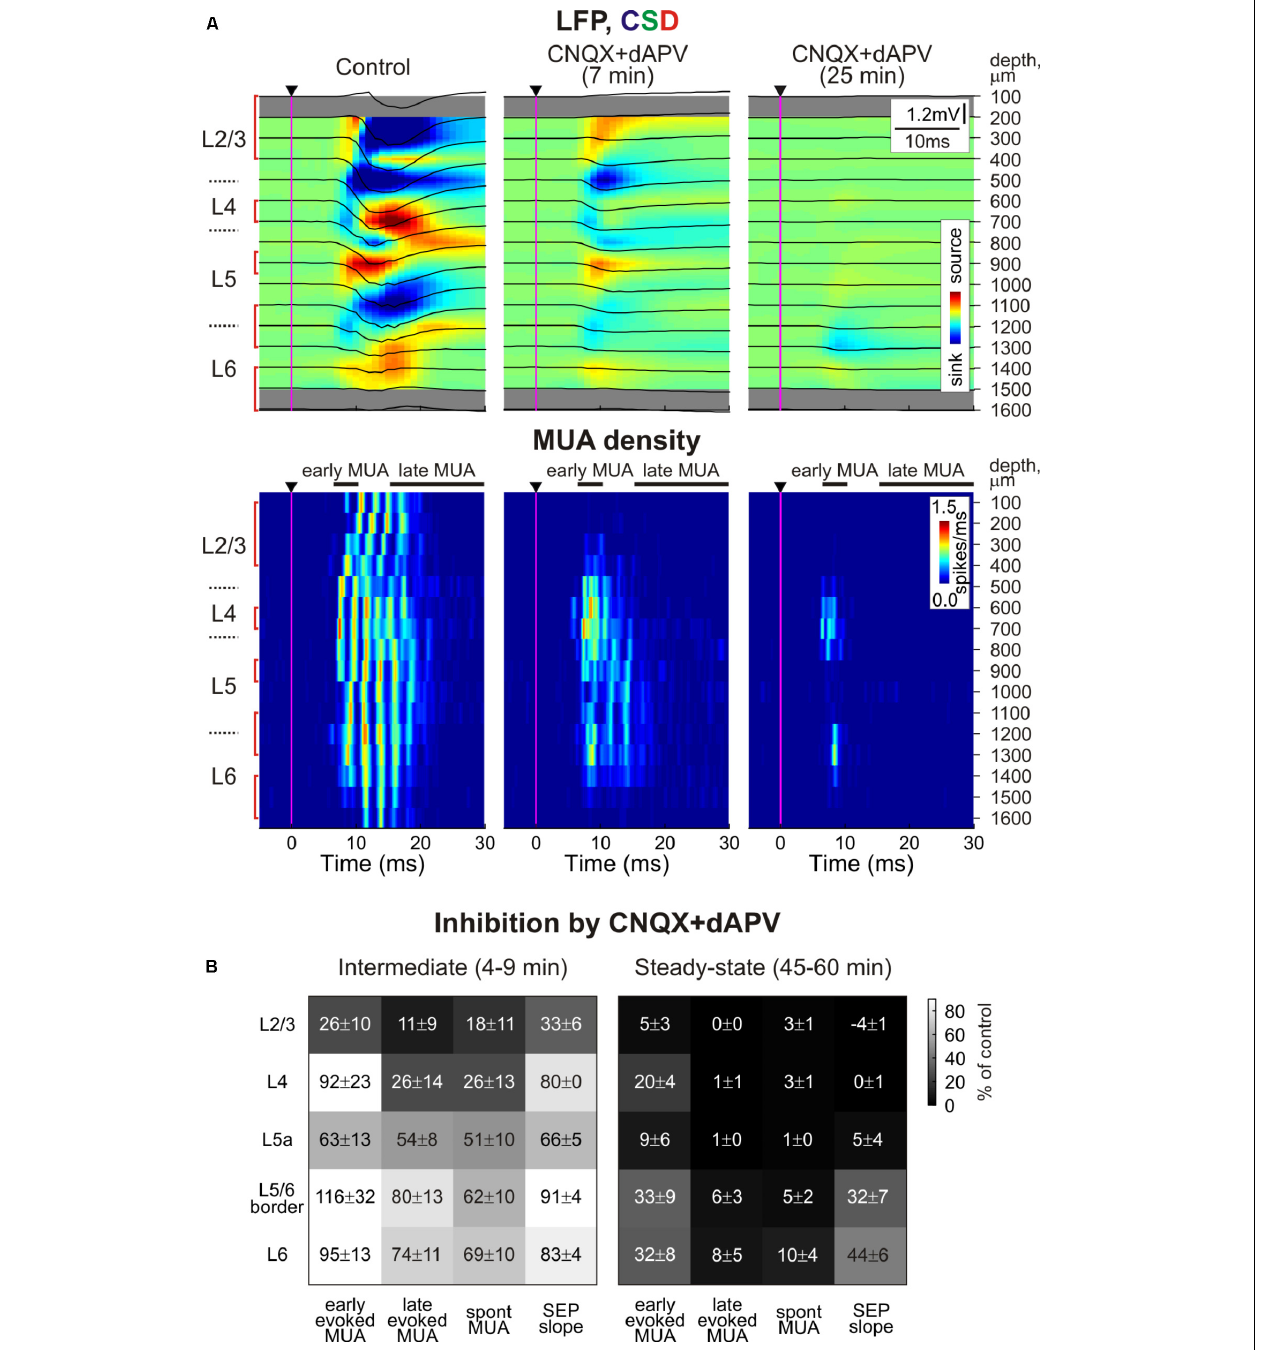
FIGURE 1 | Depth profile of CNQX and dAPV action on barrel cortex activity. (A) Top , Stimulus-triggered LFP averages (black traces) of sensory responses evoked by principal whisker deflection across cortical depths of corresponding barrel column overlaid on color-coded current source density plot (CSD) in control, 7 and 25 min after 500 µ M CNQX and 2 mM dAPV application (25 responses were averaged for each CSD plot). Bottom , corresponding stimulus-triggered averages for MUA. Stimulus onset is indicated by the black arrowhead and vertical magenta line. The cortical layer borders are shown left of the CSD and MUA density plots, and recording electrode depths are shown on the right. Red square brackets indicate the electrodes of the recording that were used for building group data plots on panel (B) . The gray bars above MUA density plots limit the time windows for early and late MUA density calculation. (B) Group data (from 11 animals and two concentrations, 170 µ M CNQX/700 µ M dAPV and 0.5 mM CNQX/2 mM dAPV) on the magnitude of CNQX and dAPV effect on early and late components of the sensory-evoked MUA, spontaneous MUA and SEP slope at the beginning of drug application (4–9 min, the time point corresponding to SEP slope reduction by 20% of control values) and at the end of 1 h of application (45–60 min). Note the gradual development of CNQX/dAPV effect from superficial toward deep cortical layers, and the persistence of early evoked L4 spikes after full blockade of SEP and nearly complete block of evoked MUA in L2/3 and L5a.